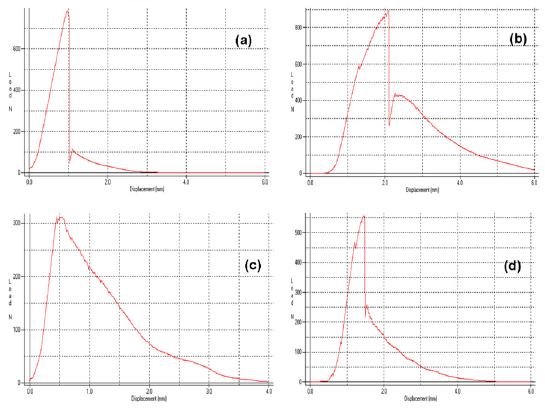
Figure 3. Load–displacement curves of ARL ( a ), FBK ( b ), GLX ( c ) and MTP ( d ). Note the stepwise loading in FBK after initial fracture.